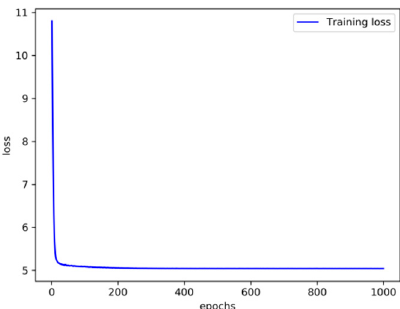
Figure 6. Training loss fluctuates with the change in the number of training rounds.